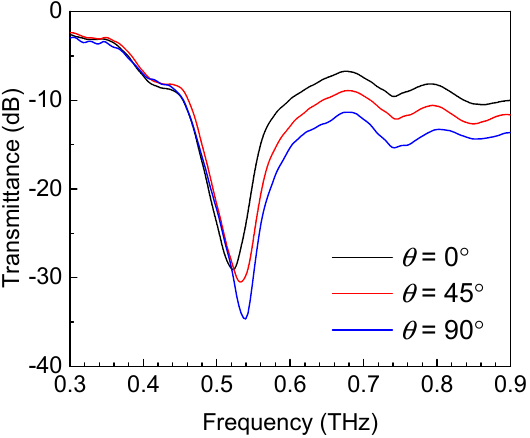
Figure 4. Experimental spectra of three metamaterial-coated LC cells at θ = 0 ° , 45 ° , and 90 ° . A simulation is performed using software to verify the experimental spectra of the three metamaterial-coated LC cells. A dielectric layer with a refractive index of n is deposited on the simulated PI-coated SRR (the inset of Figure 3). Figure 5 displays the terahertz spectra of the simulated PI-coated SRR with the dielectric layer at n = 1.55, 1.62, and 1.70. This SRR has simulated resonance frequencies of 0.551, 0.542, and 0.533 THz at n = 1.55, 1.62, and 1.70, respectively. The resonance frequency of the simulated PI-coated SRR with the dielectric layer at n = 1.70 (1.55) equals that of the metamaterial-coated